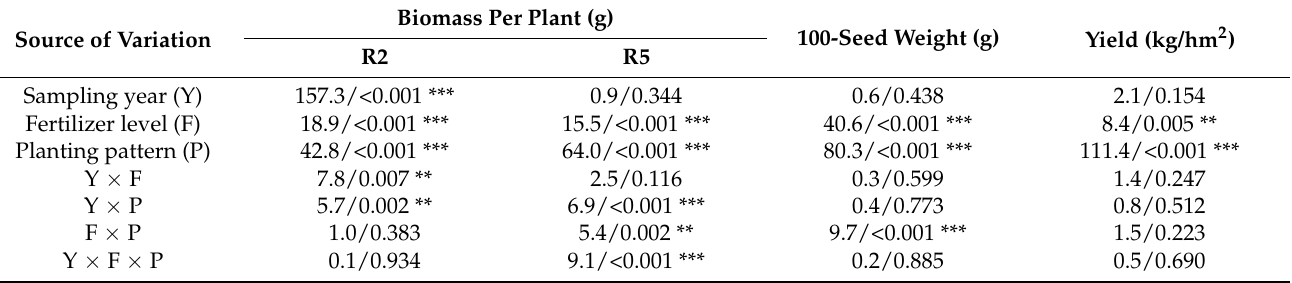
Table 1. Three-factor analysis of variance of soybean plant biomass, 100-seed weight and yield between/among different sampling years (Y; 2018 vs. 2019), fertilizer levels (F; normal vs. reduced), intercropping planting patterns (P; sole-crop soybean and three soybean intercropping planting patterns with corn) and their bi-/tri-interactions ( F / p value).